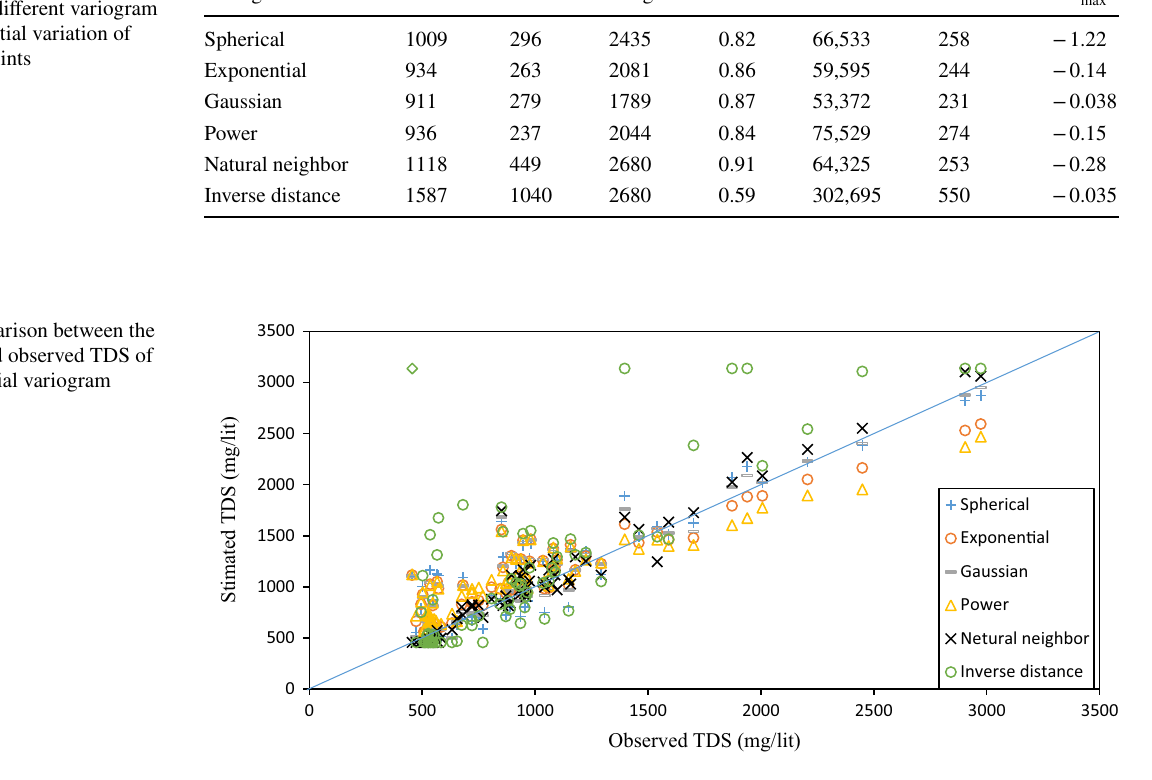
measures of different variogram to predict spatial variation of TDS in 21 points